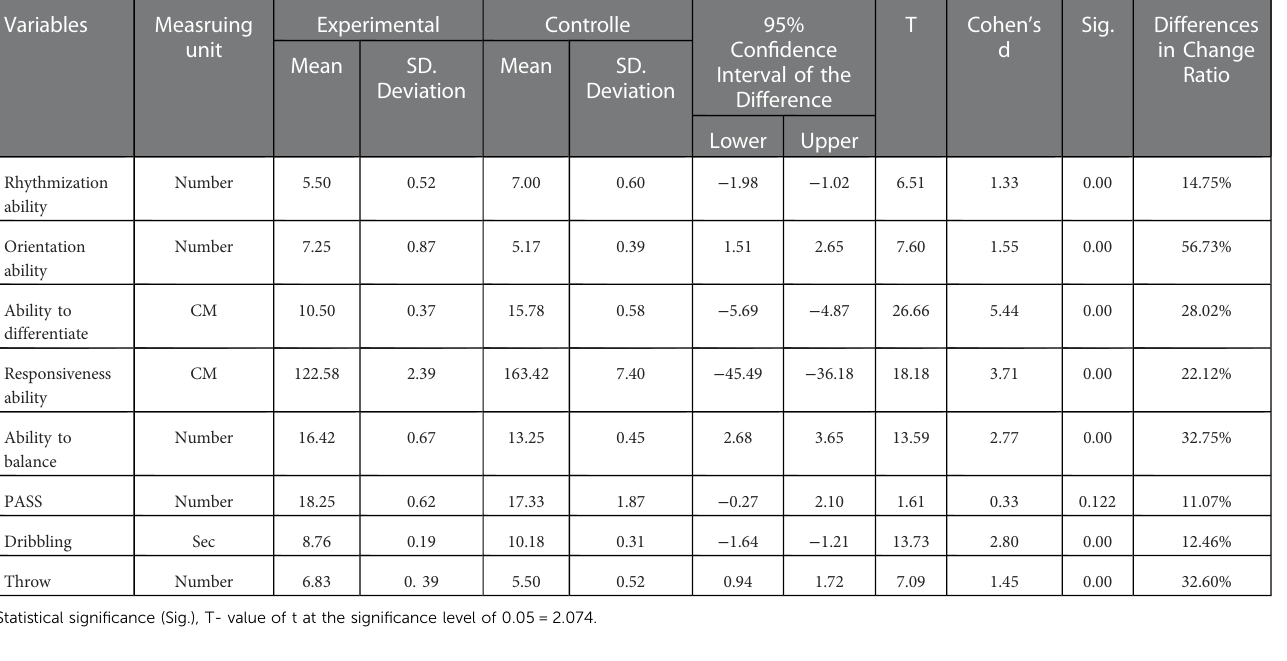
TABLE 5 Indicates the differences between the averages of post measurements of the experimental and controlled groups in the variables under consideration ( n =24) Variables Measruing Experimental Controlle 95% unit RatioMean SD. SD.